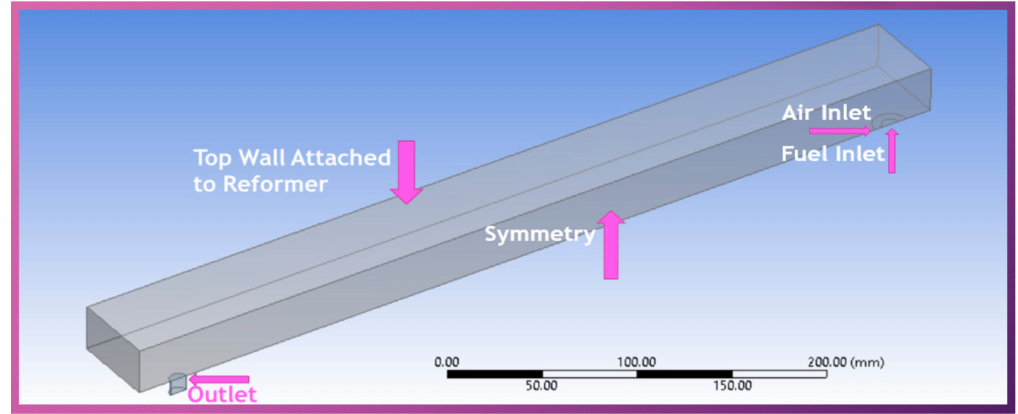
Figure 3. The 3D geometry model of combustor developed using ANSYS Design Modeler ® and half symmetry.